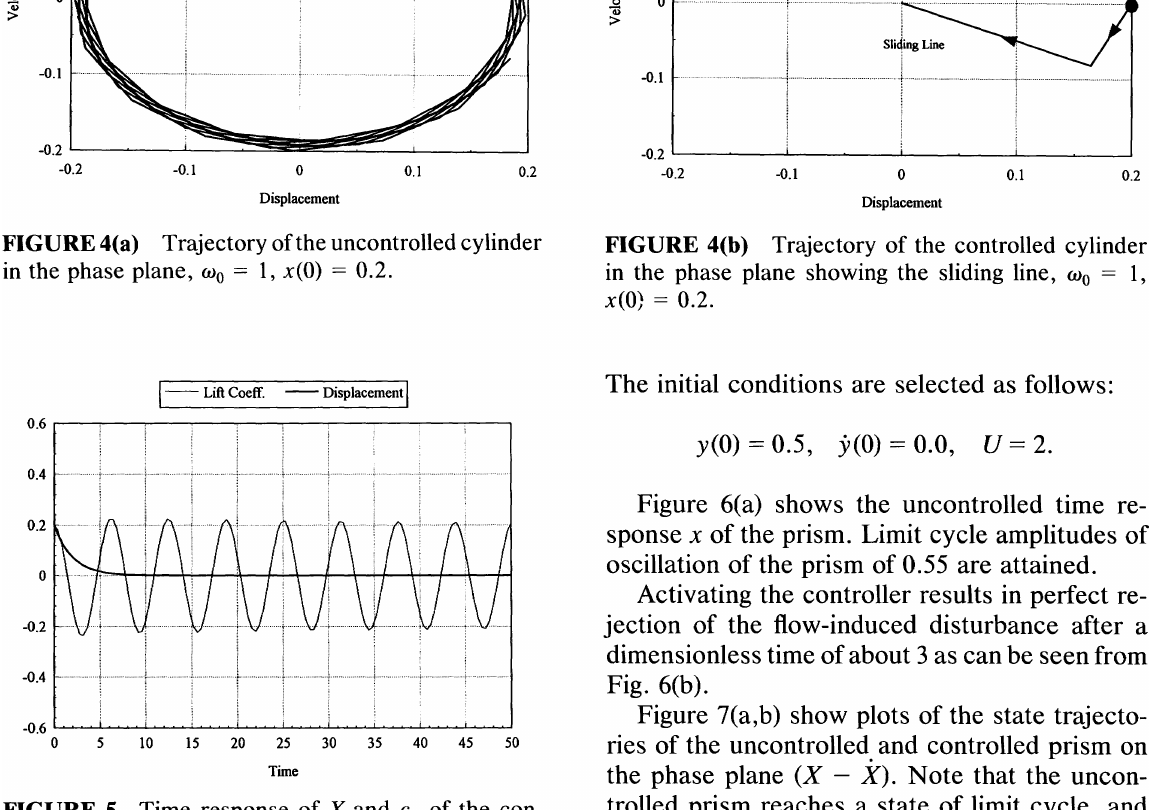
FIGURE 5 Time response of X and CL of the con trolled cylinder with 50% uncertainity in natural fre quency, Wo = 2, x(O) = 0.2.